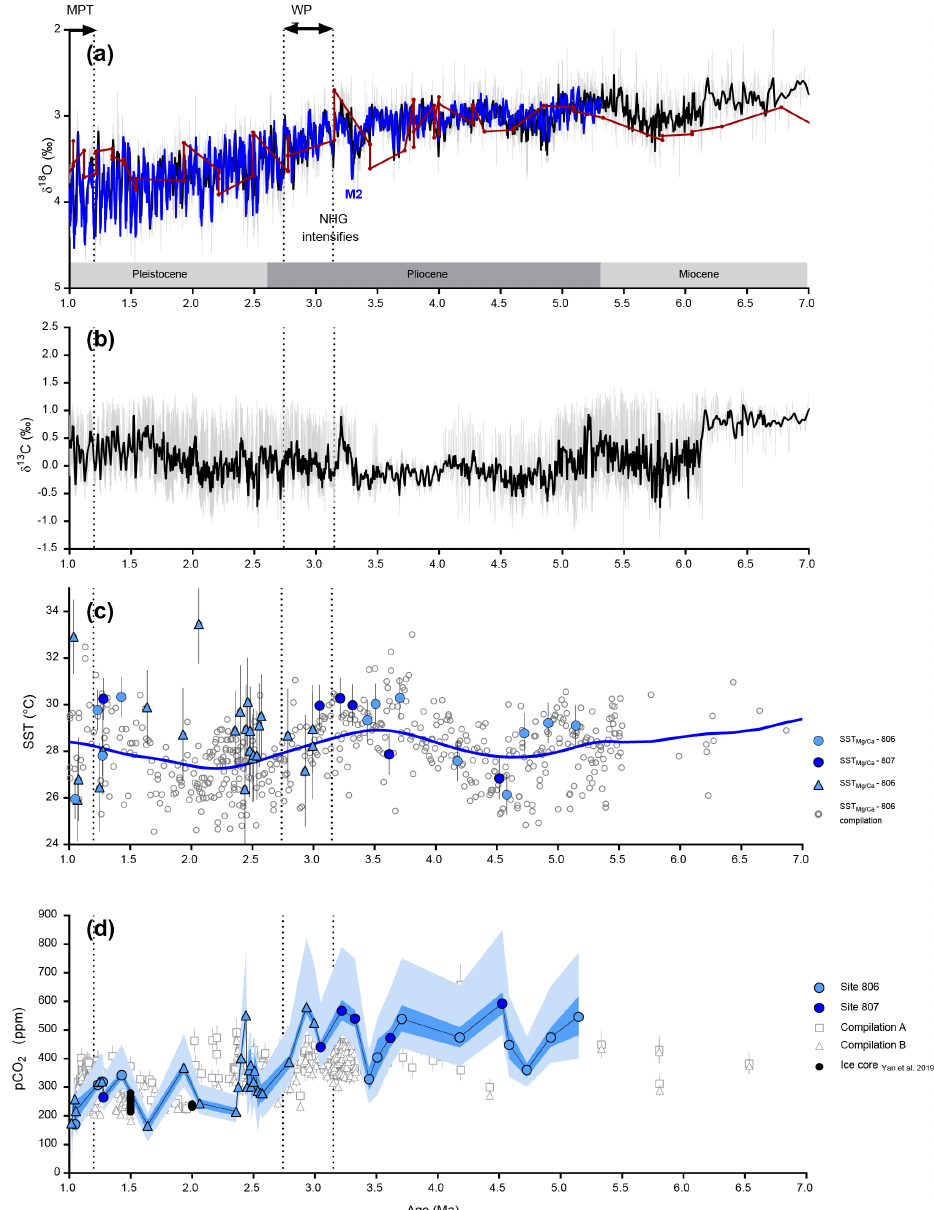
Figure 9. Proxy data from 7 to 1 million years, including the Warm Pliocene Transition (WPT), in the Western Equatorial Pacific compared to benthic oxygen isotope data. (a) Benthic δ 18 O (black line – compilation from Zachos et al., 2008). (b) Benthic δ 13 C (black line – compilation from Zachos et al., 2008). (c) – (d) Color indicates the site (filled light blue = 806, filled dark blue = 807), symbols represent the species (circle = T. sacculifer and triangle = G. ruber ), filled grey squares are recalculated data based on Sosdian et al. (2018) at ODP Site 872. (c) SST reconstructed at ODP Sites 806 and 807 using Mg / Ca ratios (see Supplement for reconstruction details), open symbols are reconstructed temperatures based on literature Mg / Ca at site 806 (see text or Fig. 4). (d) Reconstructed p CO 2 (ppm) from this study (blue symbols) using boron-based pH and alkalinity from Caves et al. (2016). Propagated uncertainties are given by Eq. (S17) for the dark blue envelope, while the light blue envelope reflects the uncertainties calculated based on Eq. (S16) (taking into account uncertainty on δ 11 B seawater ). Open squares (compilation A) are p CO 2 compilation from Sosdian et al. (2018), open triangles (compilation B) are from the compilation by Rae et al. (2021). Data for compilation A are from Hönisch and Hemming (2009); Seki et al. (2010); Foster et al. (2012); Badger et al. (2013); Greenop et al. (2014); Martínez-Botí et al. (2015a); Chalk et al. (2017); Sosdian et al. (2018). Data for compilation B are from Foster (2008); Hönisch and Hemming (2009); Seki et al. (2010); Foster et al. (2012); Badger et al. (2013); Greenop et al. (2014); Martínez-Botí et al. (2015a); Chalk et al. (2017); Dyez et al. (2018); Sosdian et al. (2018); Greenop et al. (2019); de la Vega et al. (2020). In black are published estimates from ice core data (circles – Yan et al., 2019).